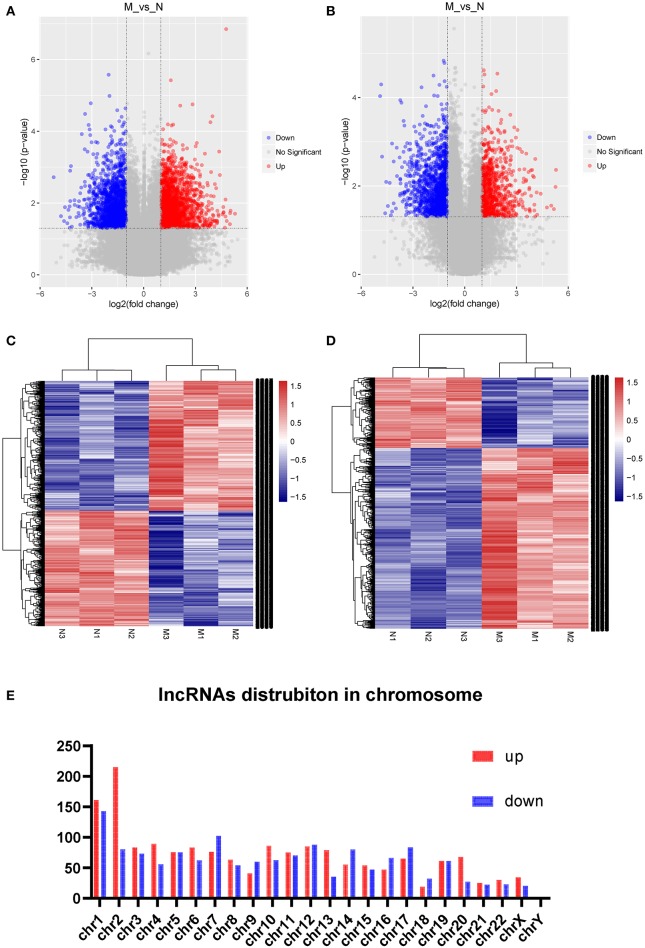
Expression profile of lncRNAs and mRNAs in AFM patients. Volcano plots were used to distinguish differentially expressed lncRNAs (A) and mRNAs (B). Hierarchical clustering analysis of differentially expressed lncRNAs (C) and mRNAs (D). Distribution of dysregulated lncRNAs in human chromosomes (E). Red and blue represent upregulated and downregulated expression, respectively. M indicates the experimental group; N indicates the normal group.